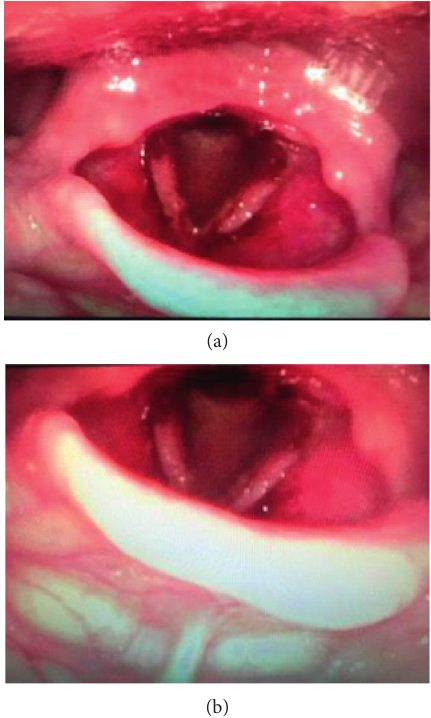
Figure 1: Bilateral vocal fold edema with ulceration of vocal folds; supraglottic and glottic epithelial bleeding.